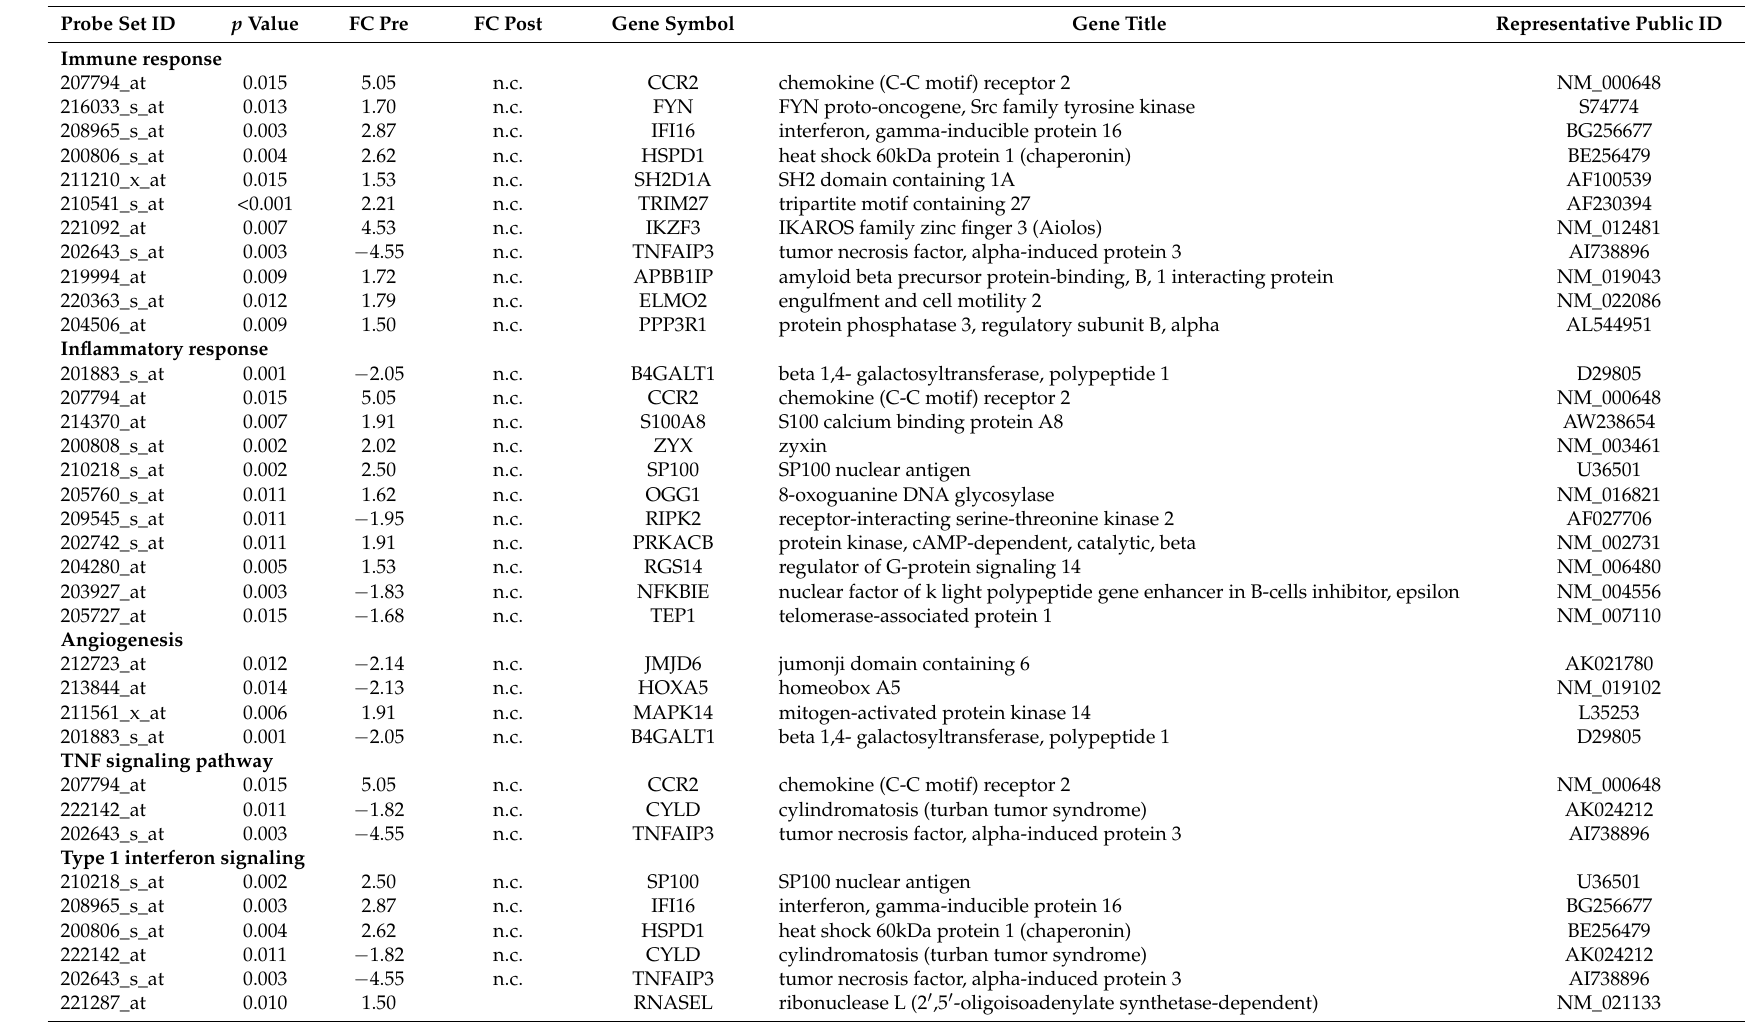
Table 5. Genes modulated only before treatment in AS patients group 1. n.c.: not